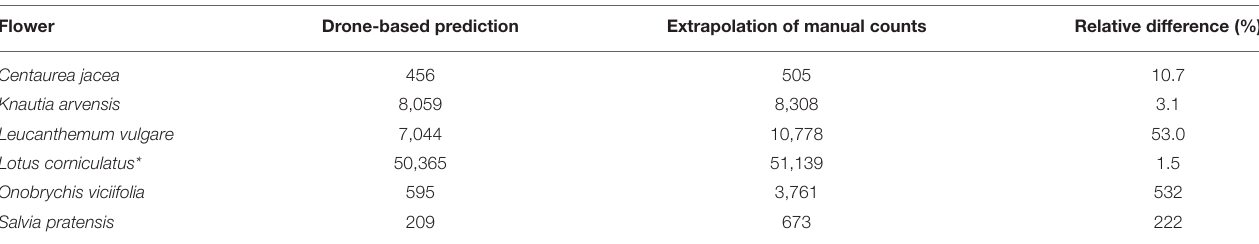
TABLE 5 | Predictions on the whole field of 730 square